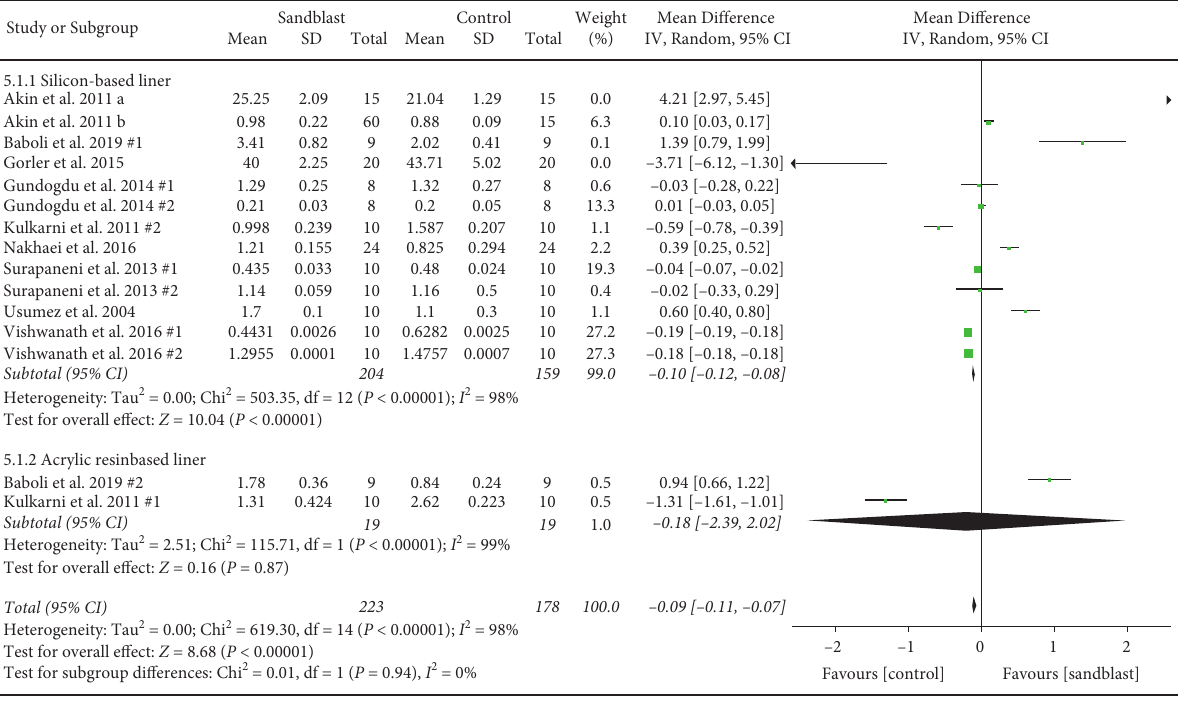
Figure 9: Forest plot for subgroup analysis of type of soft liner for tensile bond